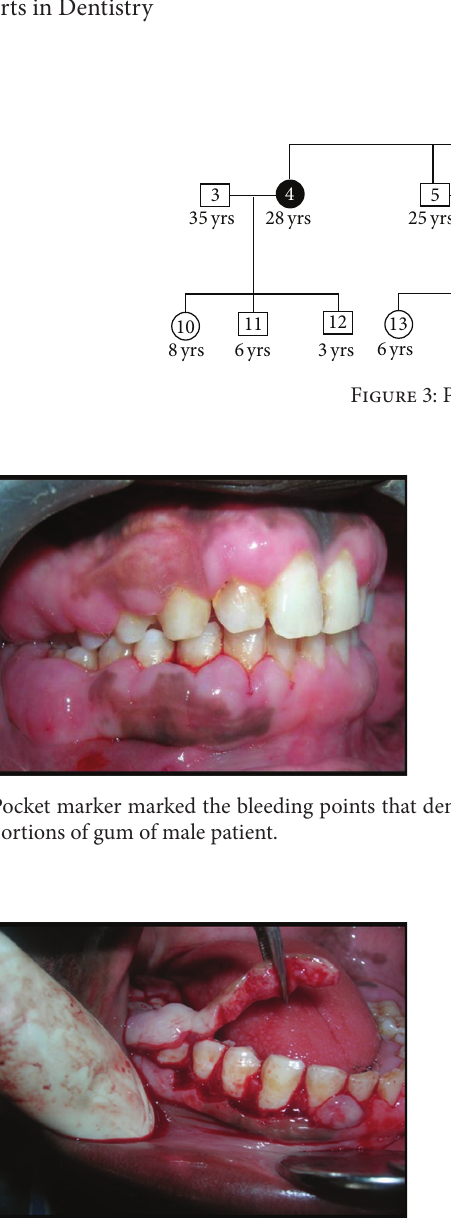
Figure 5: Internal bevel gingivectomy was done to remove the excess tissue of the male patient.